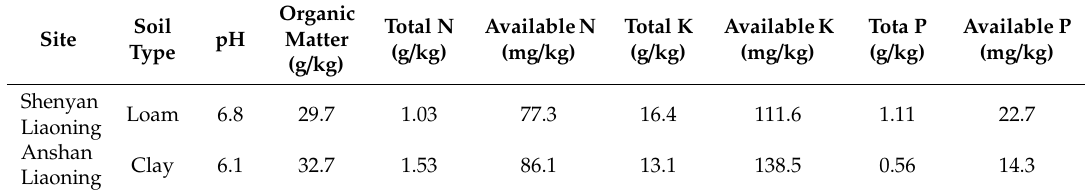
Table 1. Physico-chemical properties of the soil at Shenyang and Anshan sampled before the start of the field experiment in